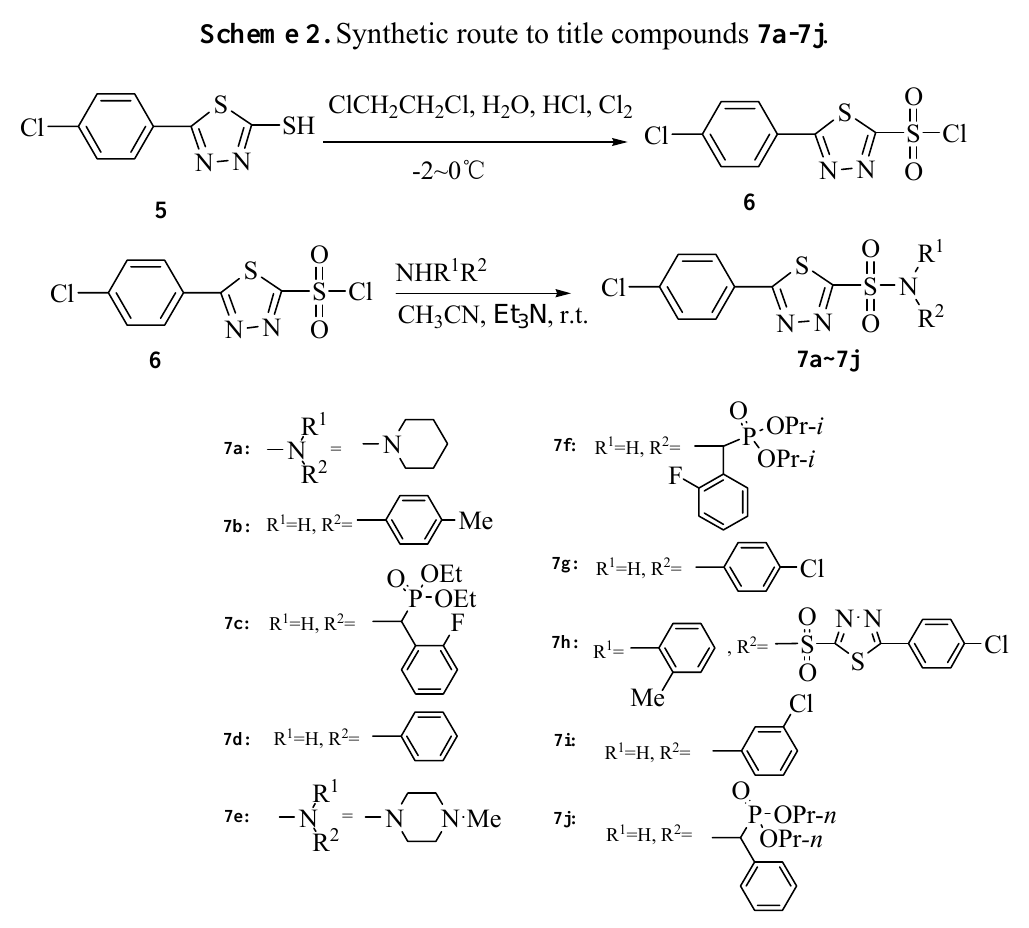
Scheme 2. Synthetic route to title compounds 7a-7j